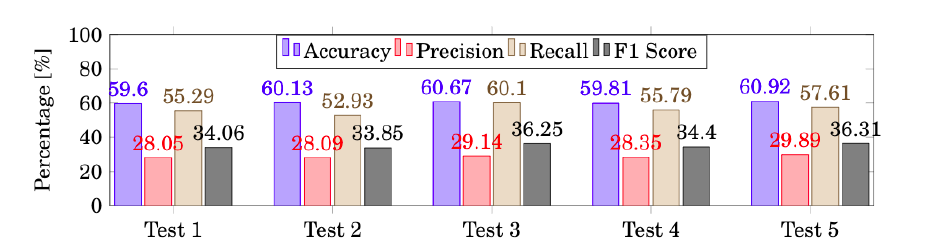
Figure 4. Evaluation Metrics per Test.